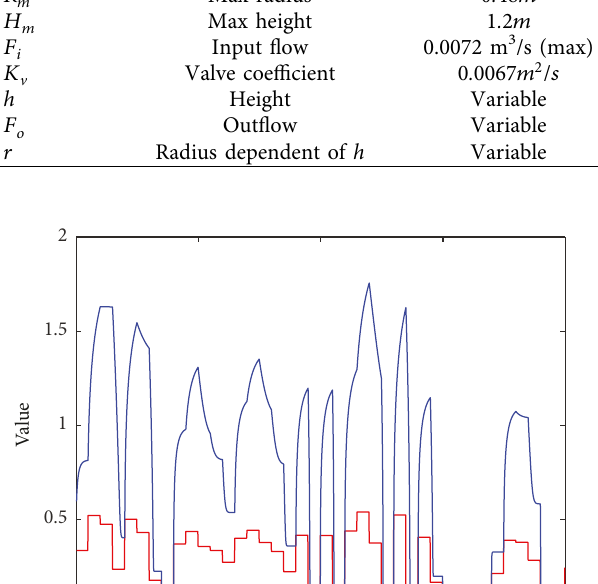
Figure 13: Data of the plant in an open loop.